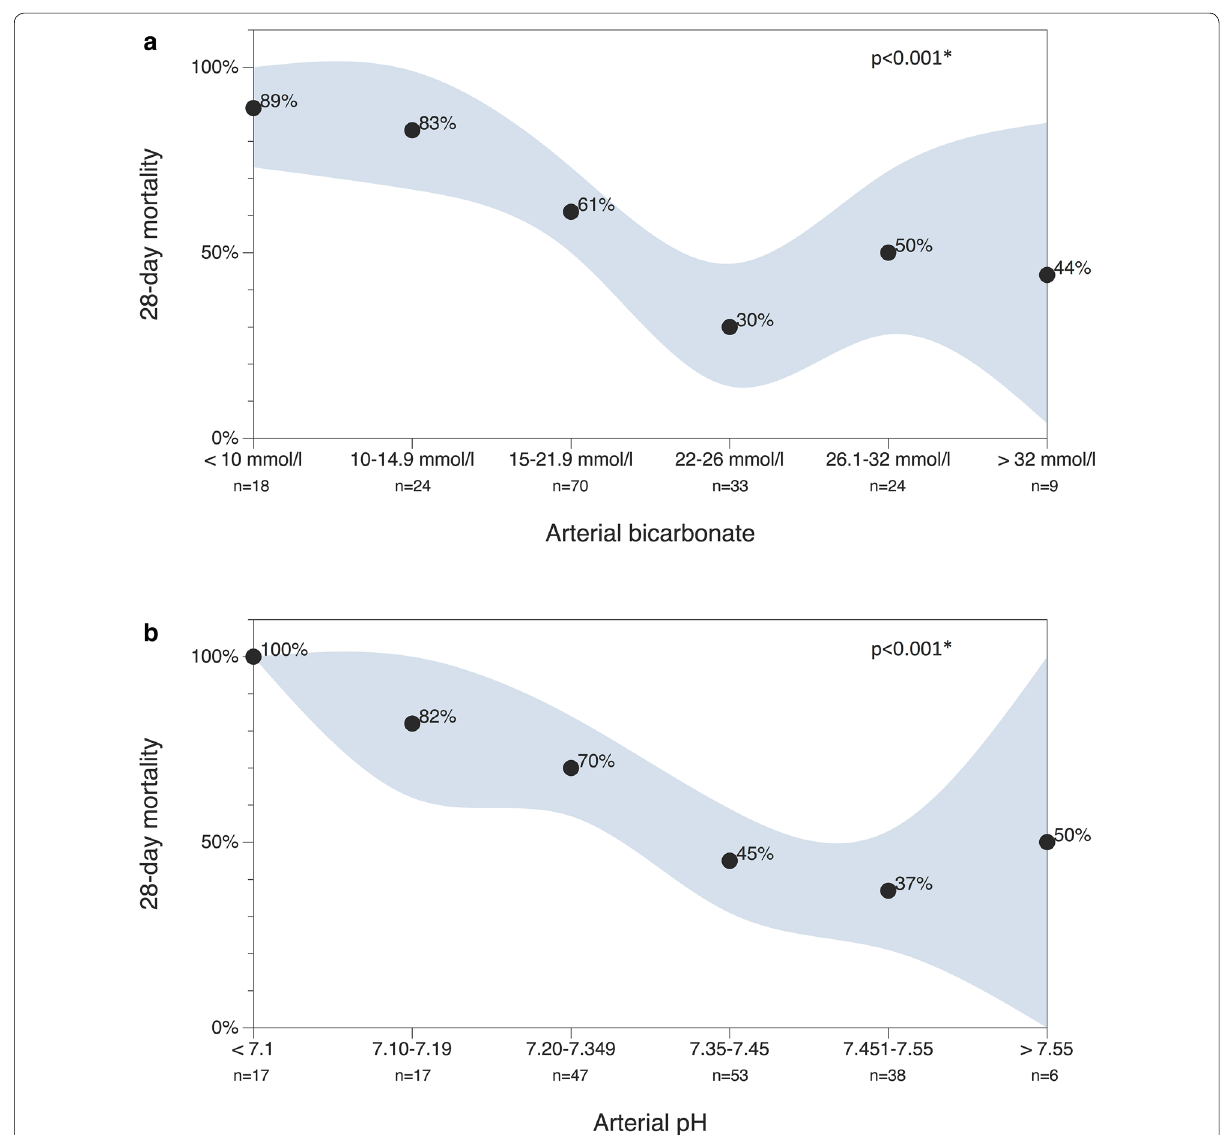
Fig. 2 Association of bicarbonate ( a ) and pH ( b ) with 28‑day mortality in critically ill patients with liver cirrhosis. Black dots: observed 28‑day mortal‑ ity rate; gray area: 95% confidence interval. * p values calculated by Chi‑square